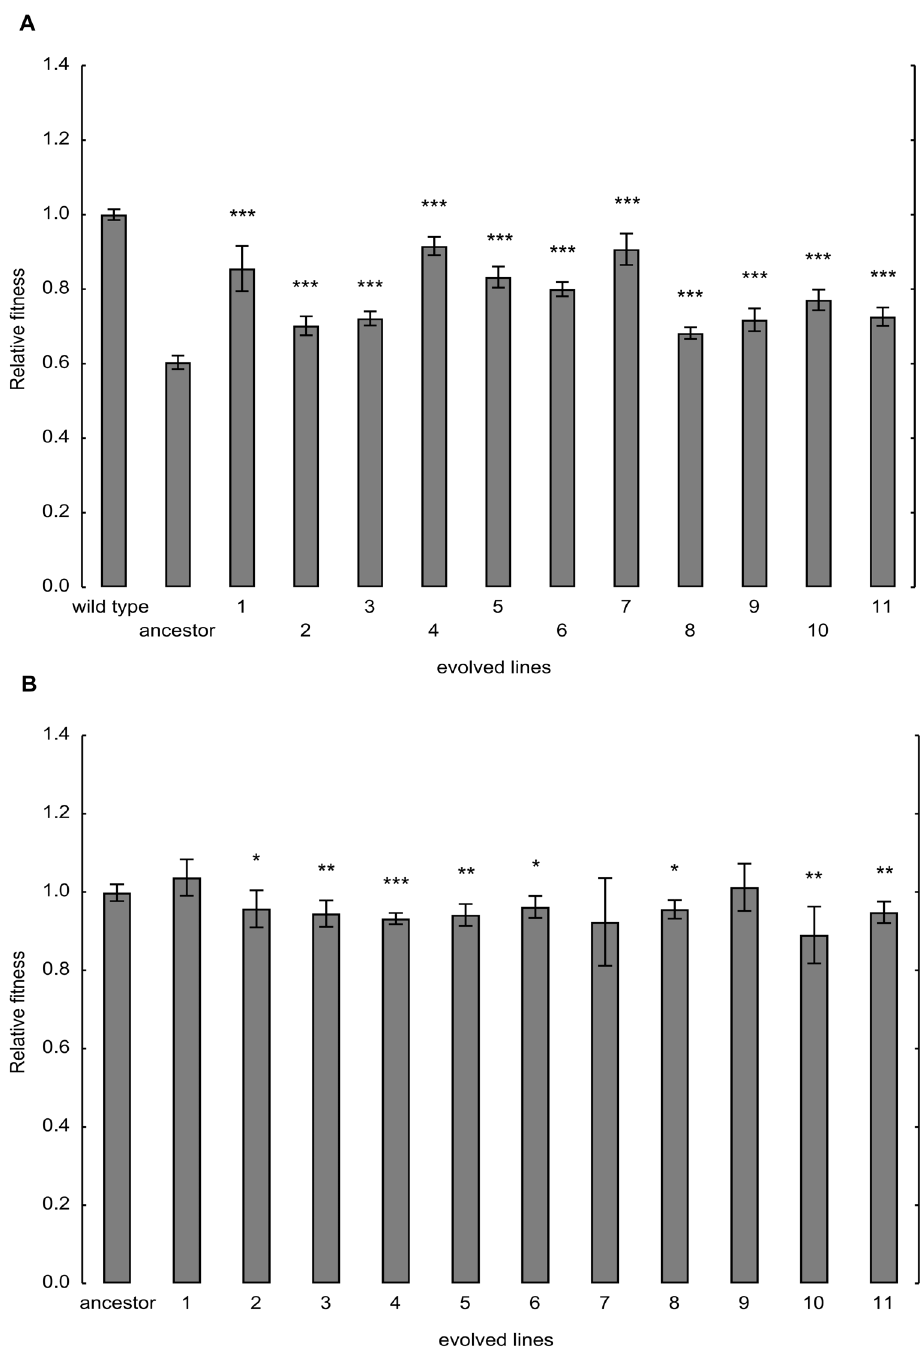
Fig 1. Fitness changes during laboratory evolution. (A) Fitness of the ancestor and the evolved lines under high mistranslation rate. The ancestor and evolved lines carry the mistranslation-causing tRNA CAGSer construct. The ancestor is isogenic to the wild type, with the only exception being that the latter carries an empty vector instead of tRNA CAGSer . Growth rate (calculated by monitoring optical density) was used as a proxy for fitness. Fitness values were normalized to the wild-type control. The bars indicate mean ± 95% confidence interval. Mann-Whitney U test was used to assess difference in fitness between ancestor and evolved lines. *** indicates p < 0.001. (B) Fitness of the ancestor and evolved lines under low mistranslation rate. tRNA CAGSer was swapped for the corresponding empty vector in the ancestor and the evolved lines. Growth rate (calculated by monitoring optical density) was used as a proxy for fitness. Fitness values